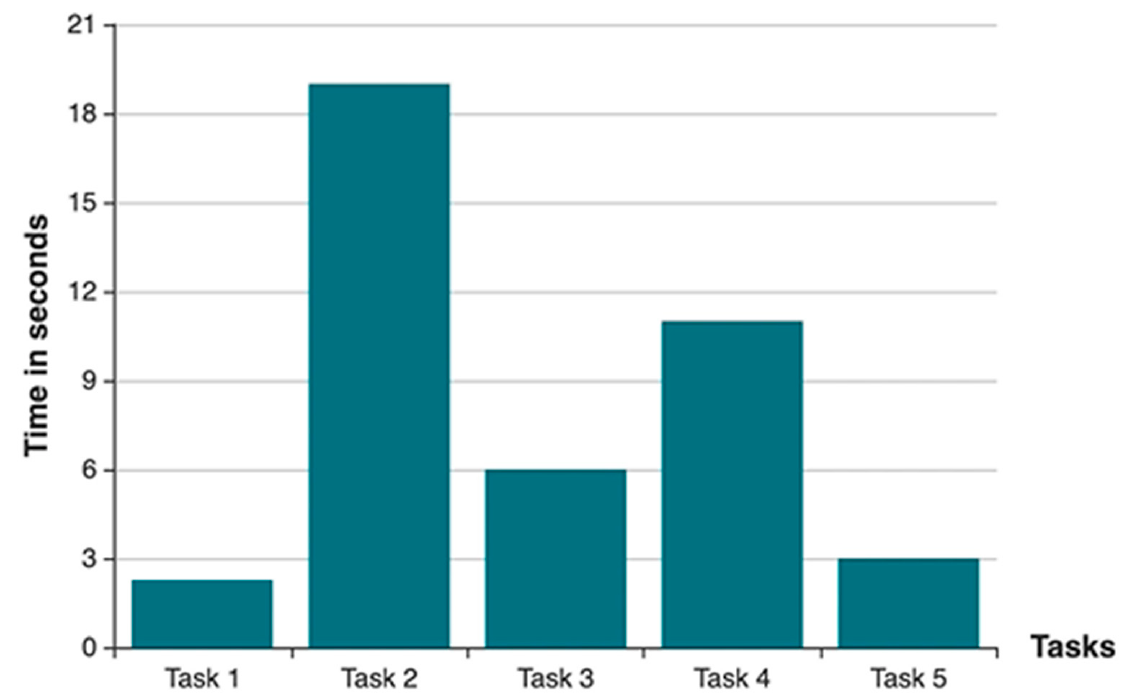
Figure 12. Efficiency chart of tasks 1 to 5 performed on the management web platform.